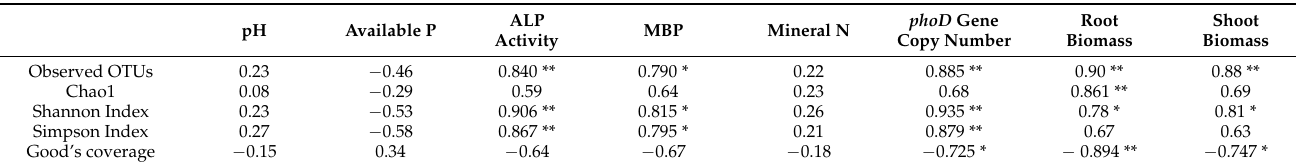
Table 2. Pearson correlation coefficient between diversity indices and soil parameters in different crops and farming practices (* p < 0.05, ** p < 0.01). ALP, alkaline phosphatase; MBP, microbial biomass P.